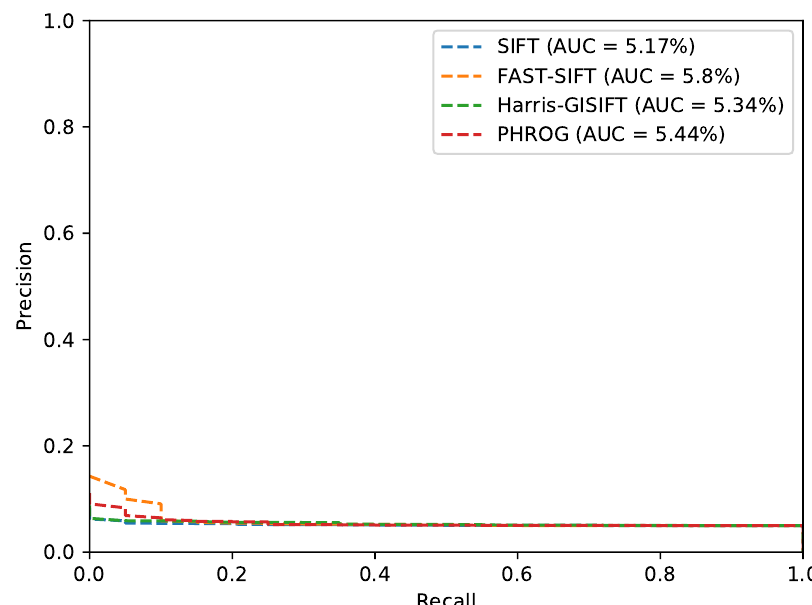
Figure 23. Precision-Recall curves from the “Long-Term” dataset and AUC ( Area Under the Curve ) for each